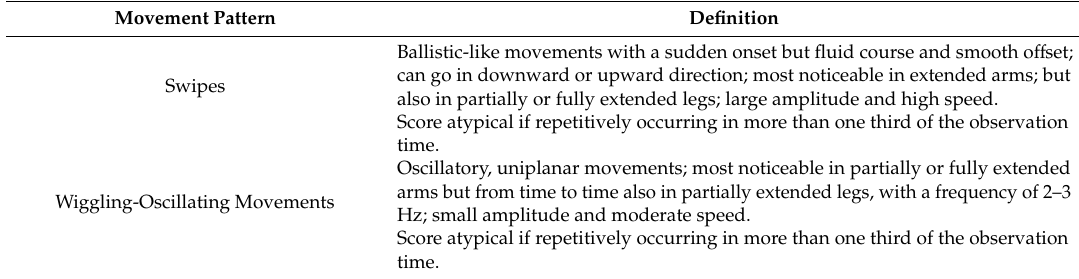
Figure 2. Consensus revised version of the Assessment of the Motor Repertoire at 3–5 months in order to obtain the Motor Optimality Score. Table 1. Definition of movement and postural patterns to be scored at 3–5 months [5,13,22–27,38,39].